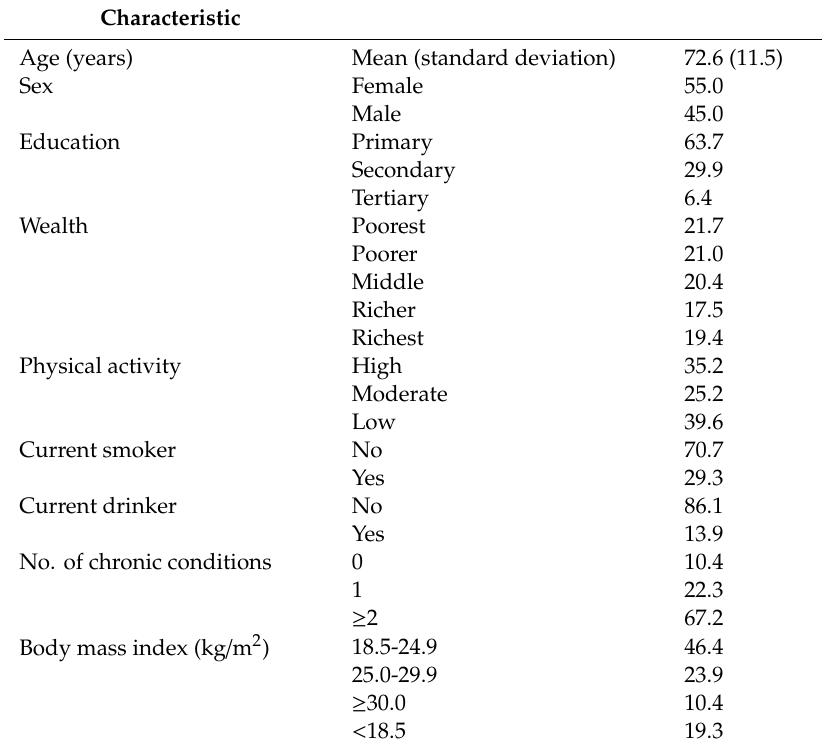
Table 1. Sample characteristics.